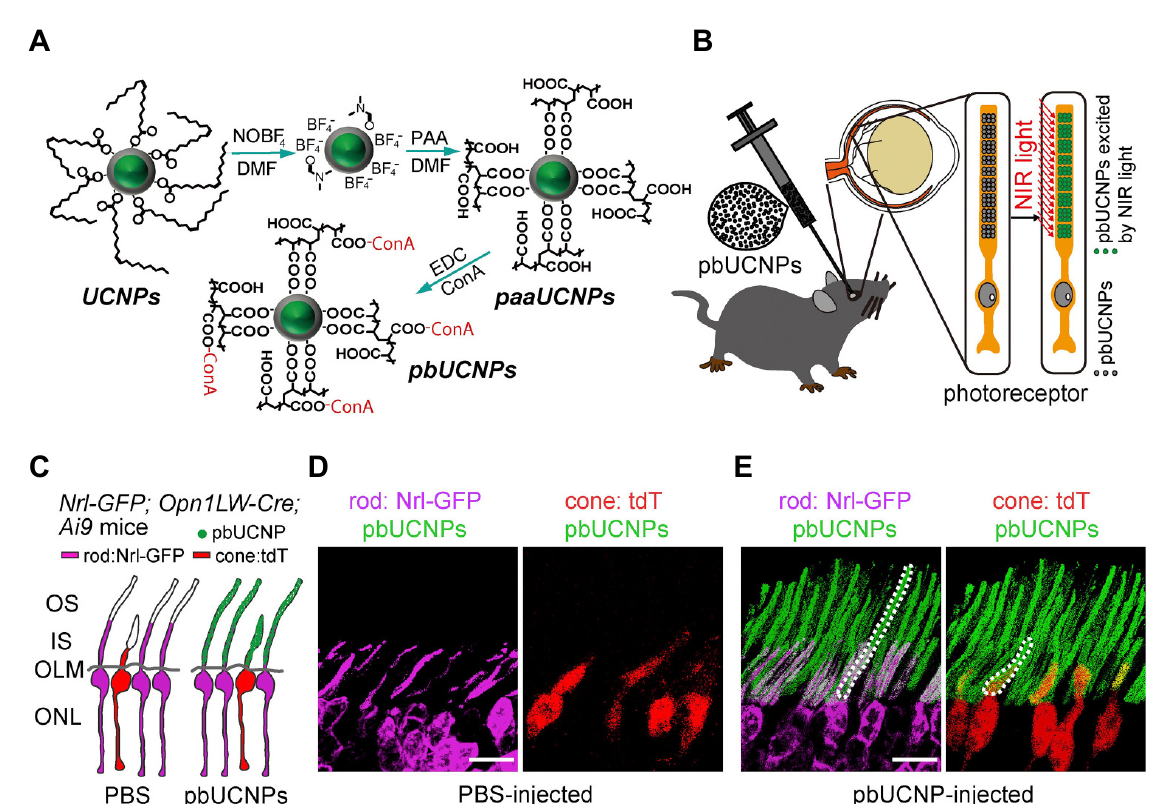
Figure 4. Photoreceptor-binding upconversion nanoparticles (pbUCNPs) and their distribution in the retina. ( A ) The surface modification for photoreceptor-binding UCNPs (pbUCNPs) is presented. ( B ) Schematic diagram to show the subretinal injection and binding of pbUCNPs to the photoreceptor outer segments and green light generation after exposure to near-infrared (NIR) light. ( C ) Schematic diagram to show pbUCNP (green) distribution in the retina. The cones were labeled with Opn1LW-Cre;Ai9-lsl-tdTomato (pseudo color red), and the rods were labeled with Nrl-GFP (pseudo color violet). ( D , E ) The mice were injected with PBS ( D ) and pbUCNP, and the self-anchored pbUCNPs (green) are presented as dashed lines in both the inner and outer segments of rods (violet) and cones (red). The outer nuclear layer is abbreviated as ONL; the outer limiting membrane is abbreviated as OLM; the inner segment of the photoreceptors is abbreviated as IS; the outer segment of the photoreceptors is abbreviated as OS. Reprinted with permission from [15]. Copyright Elsevier, 2019.